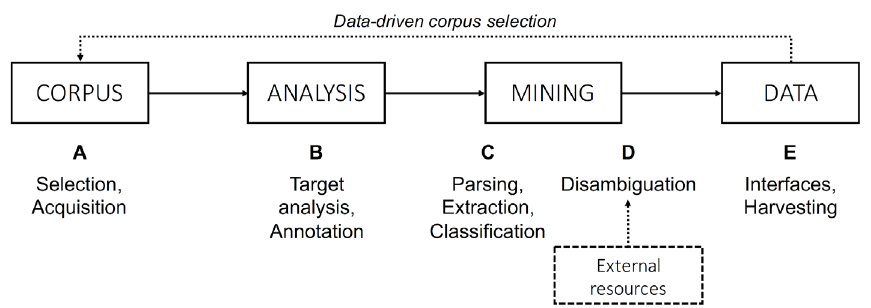
Fig. 1 The citation mining framework used for